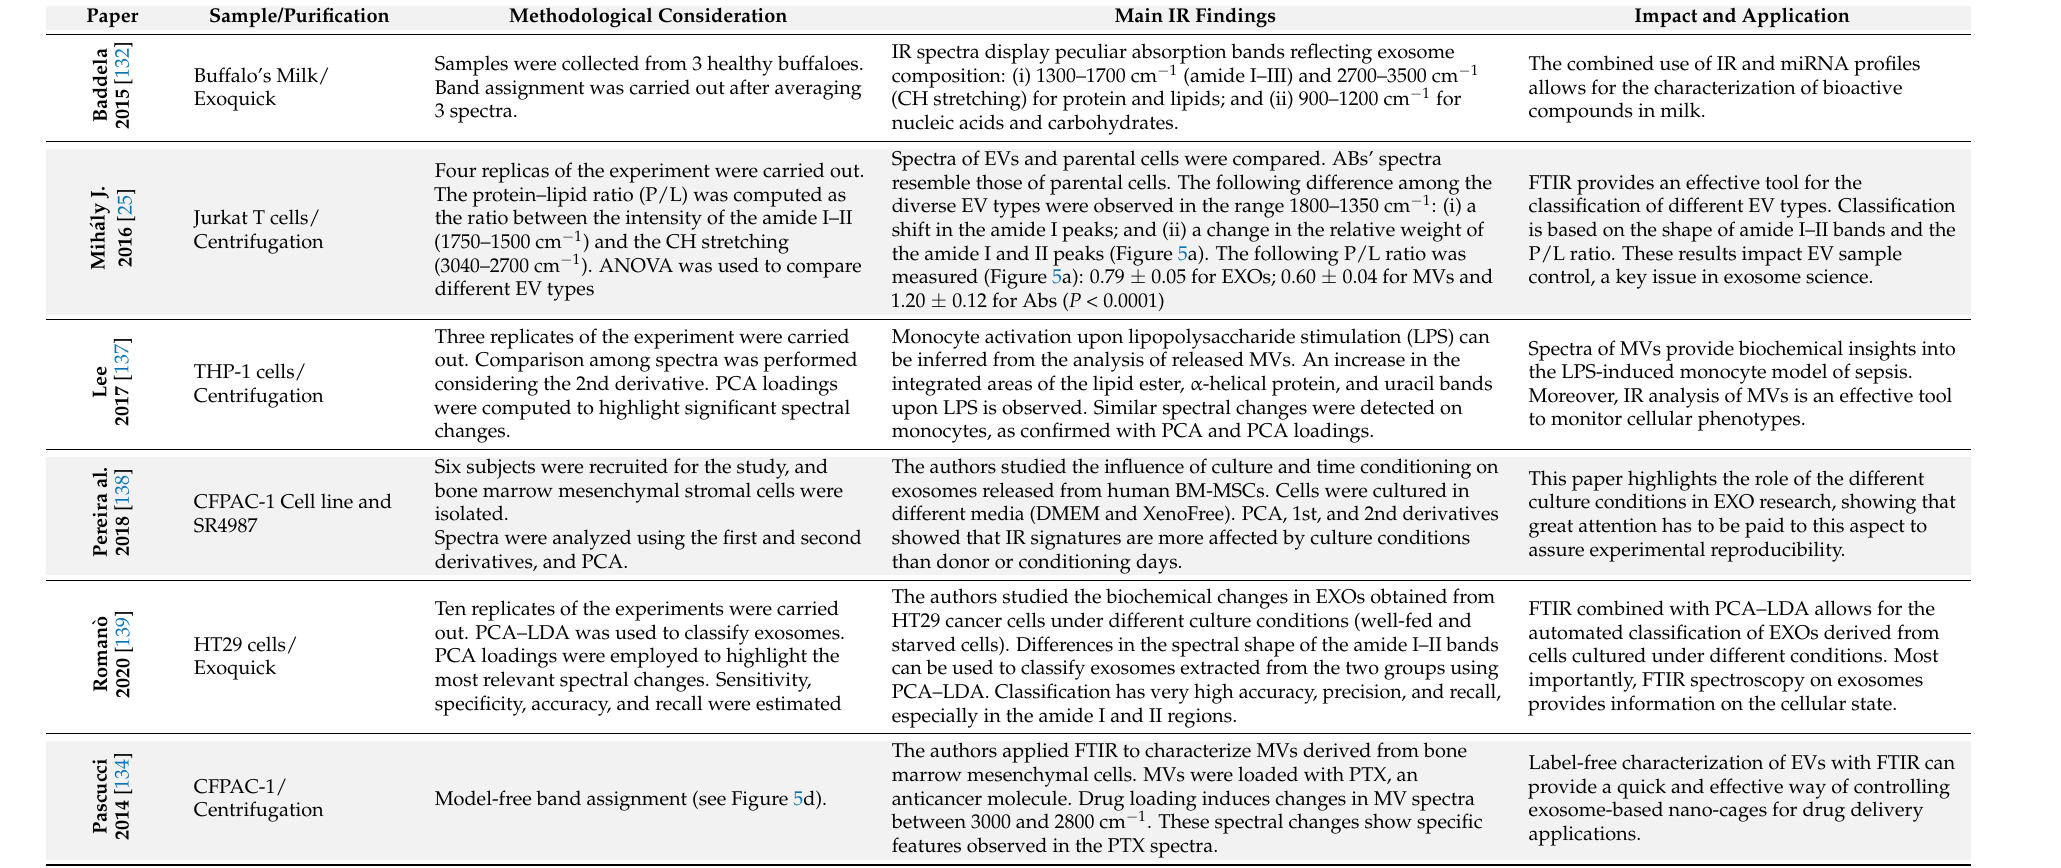
Table 3. Summary of selected papers in the literature studying EV biochemical composition with FTIR